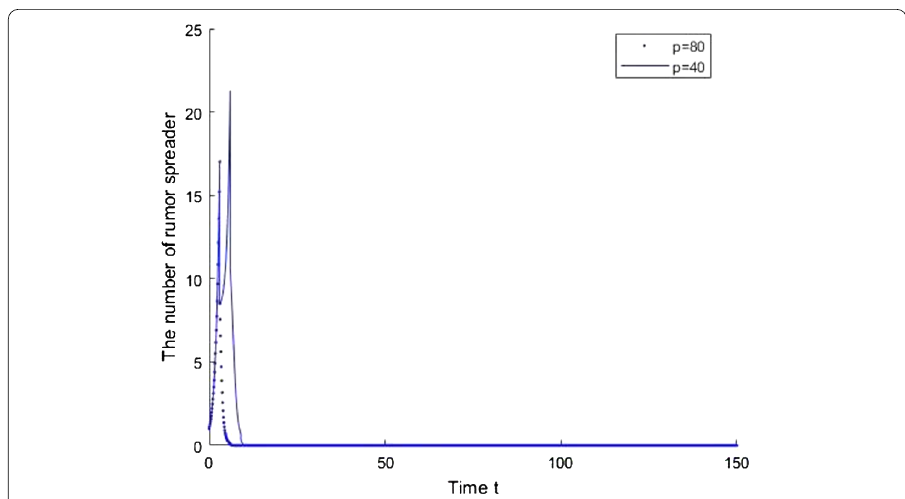
Figure 4 When p > p thr , the evolution graphs with different p of x ( t ) both tend to 0